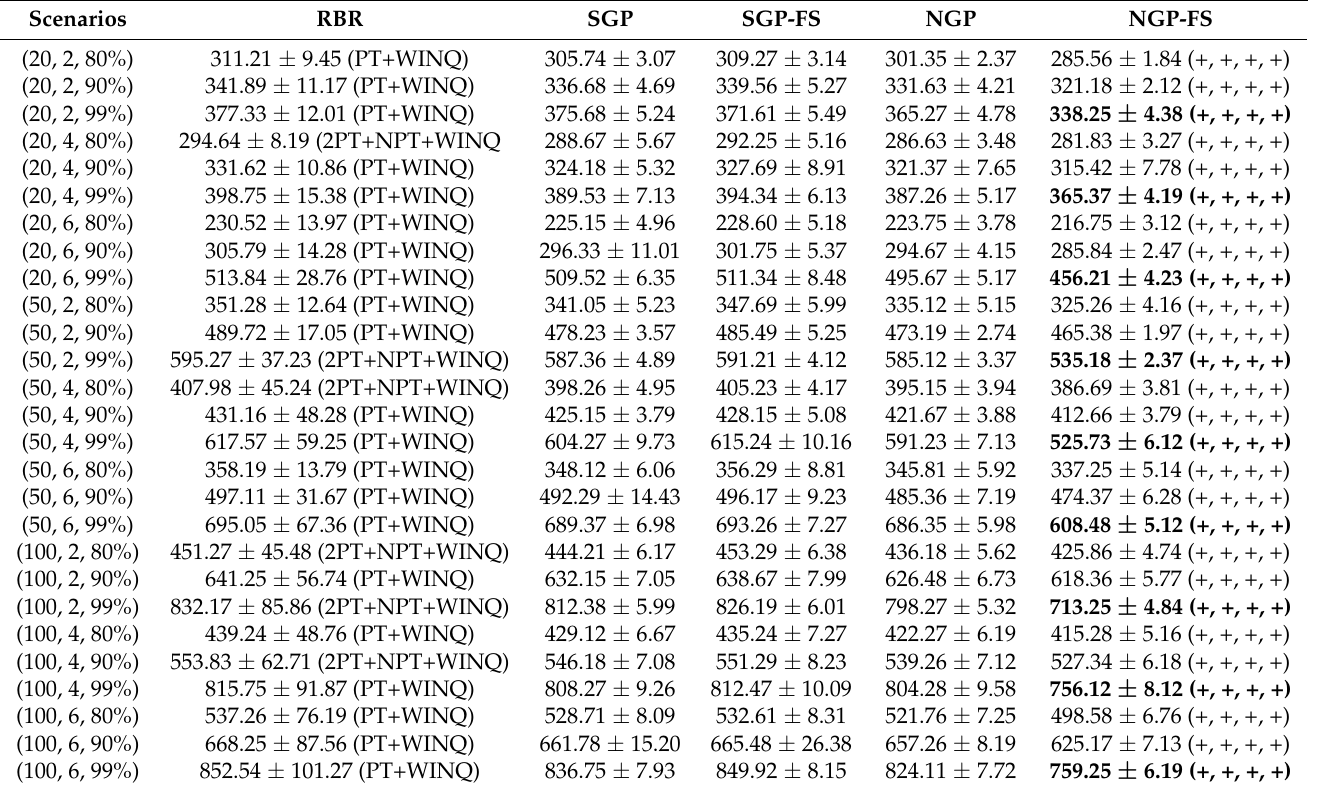
Table 8. Mean and standard deviation of the MFT objective value of the considered algorithms in the testing